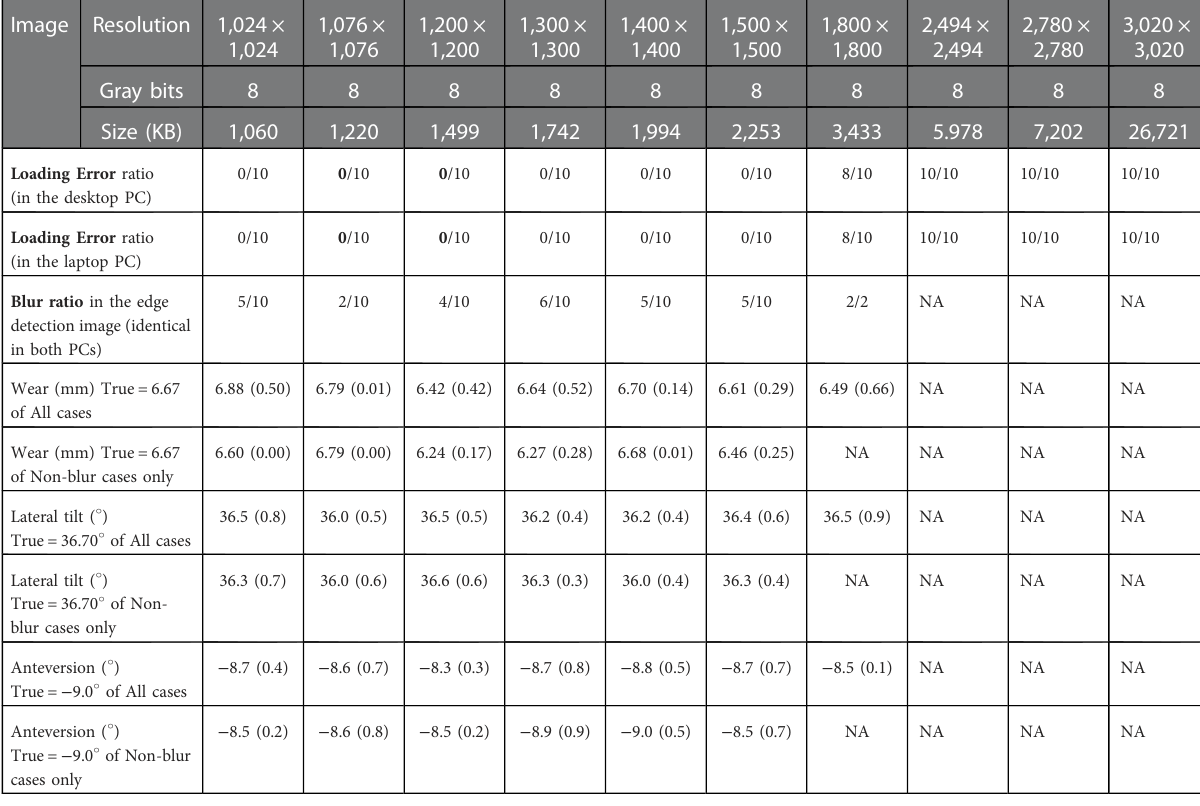
TABLE 2 Polyware compatibility tests of multiple TIFF x-ray image sizes. Image